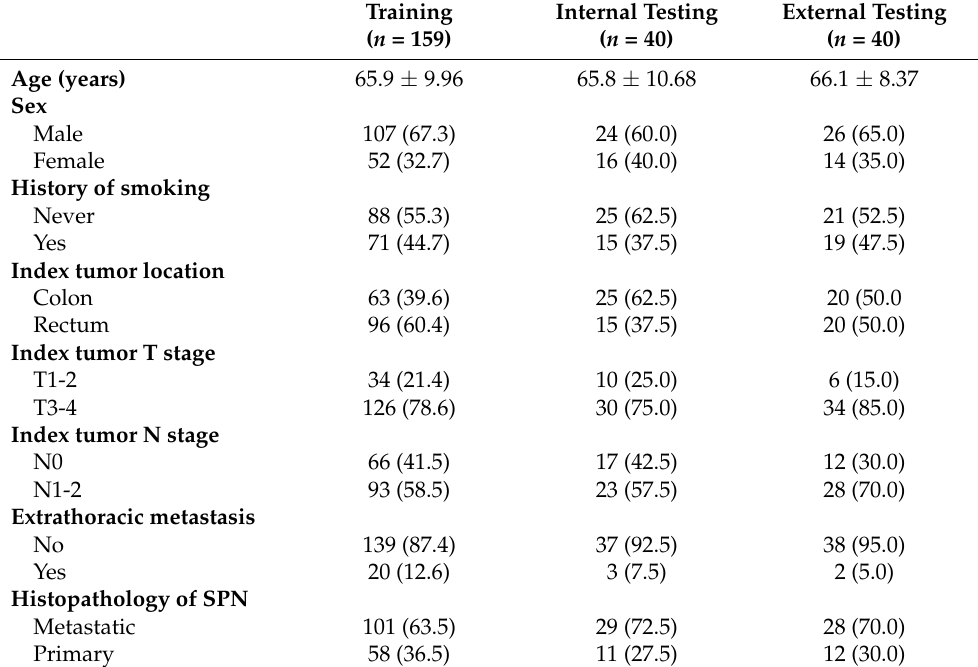
Table 1. Clinical characteristics of patients in the training, internal, and external testing datasets.